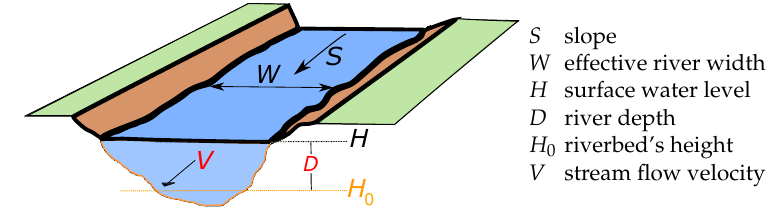
Figure 2. A schematic representation of a river with observable parameters (black) and unobservable ones (red, orange) from space. H 0 is the average riverbed’s height that does not correspond to the height of the deepest location in the channel